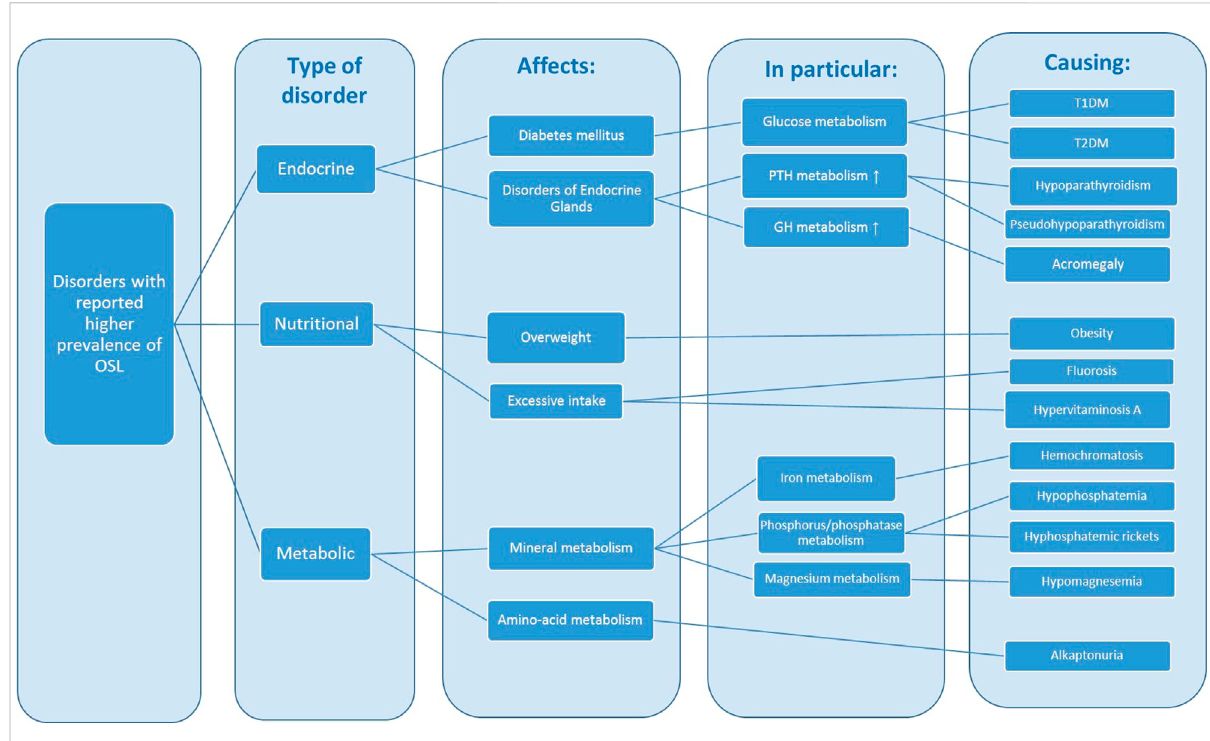
FIGURE 1 Disorders associated with a higher prevalence of OSL. GH: growth hormone, PTH: parathormone, IGF-A: insulin growth factor 1, HGA: homogentisic acid.